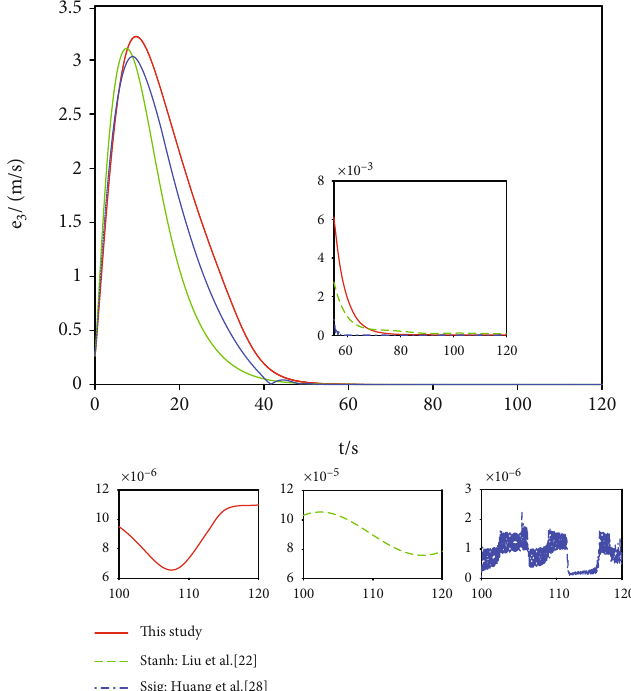
Figure 12: Relative translational velocity error curves.